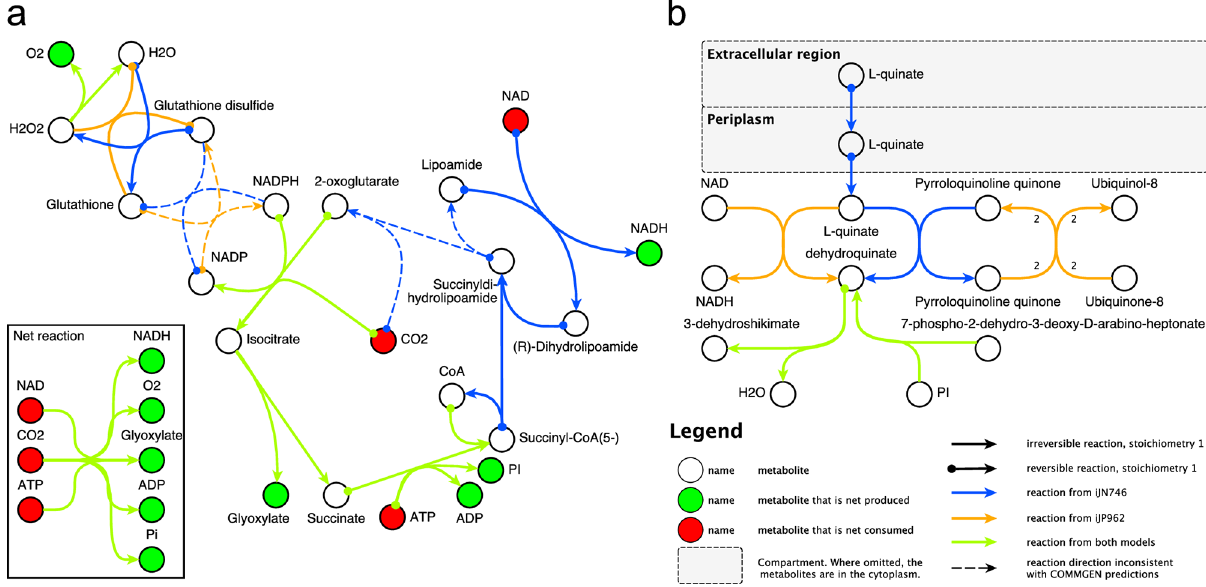
Fig 4. Subnetwork analysis for P . putida . ( a ) Example error of ‘ na ï ve ’ iGSM merging where the initial P . putida BCM contains a biologically inaccurate carbon dioxide fixation cycle due to incorrect directionalities in the IGSMs. This error is automatically resolved as COMMGEN assigns reaction directionalities opposite to those shown with dashed reaction arrows. ( b ) Example for a new metabolic function in the consensus model. P . putida can grow on L-quinate as its sole carbon source. Neither of the initial models captures this behavior, whereas the consensus model provides the necessary, complementary